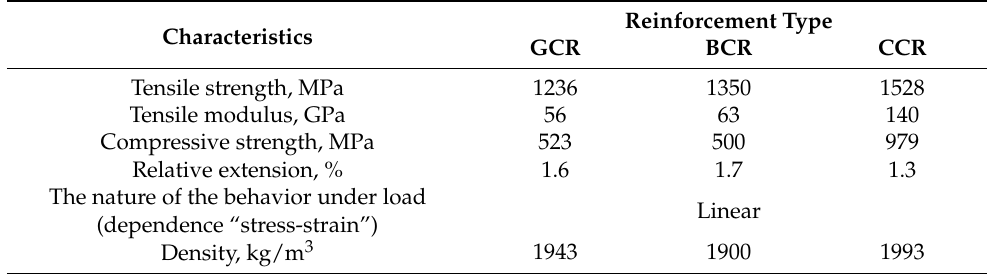
Table 1. Main physical and mechanical properties of